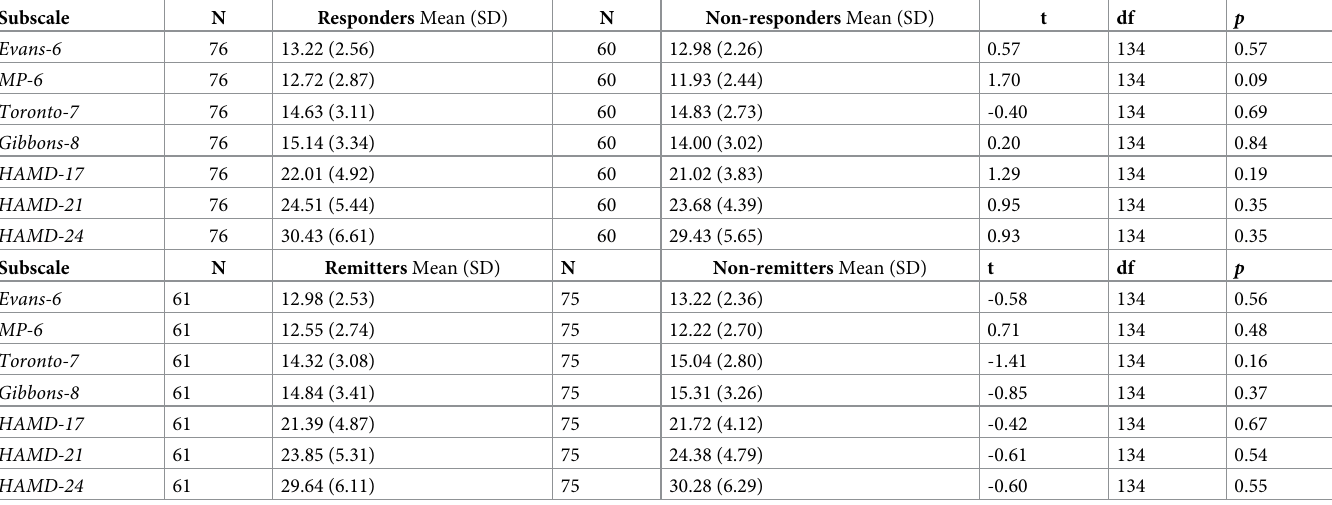
Table 2. Baseline depression severity for responders and